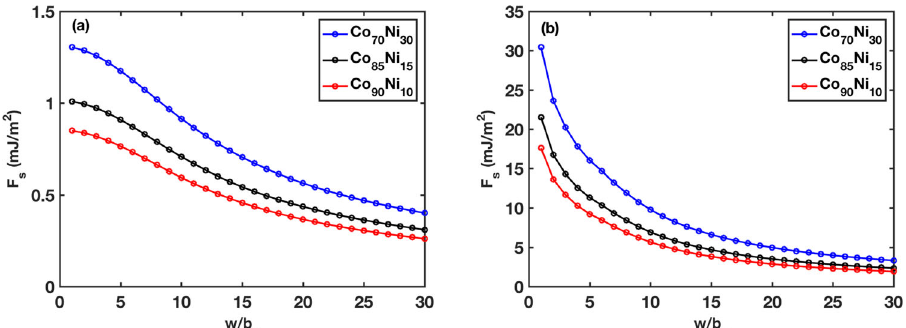
Fig. 8 Estimation of solute/dislocation interaction. The force per unit length of a partial dislocation exerted by solutes F s is computed as a function of glide distance from ( a ) reduced elastic interactions model and ( b ) direct solute – dislocation interaction